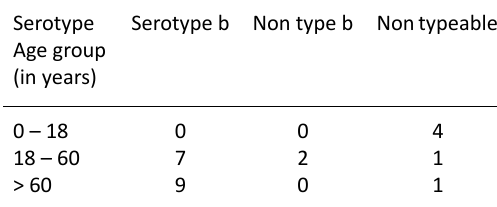
Table 1. Serotype distribution of H. influenzae by age